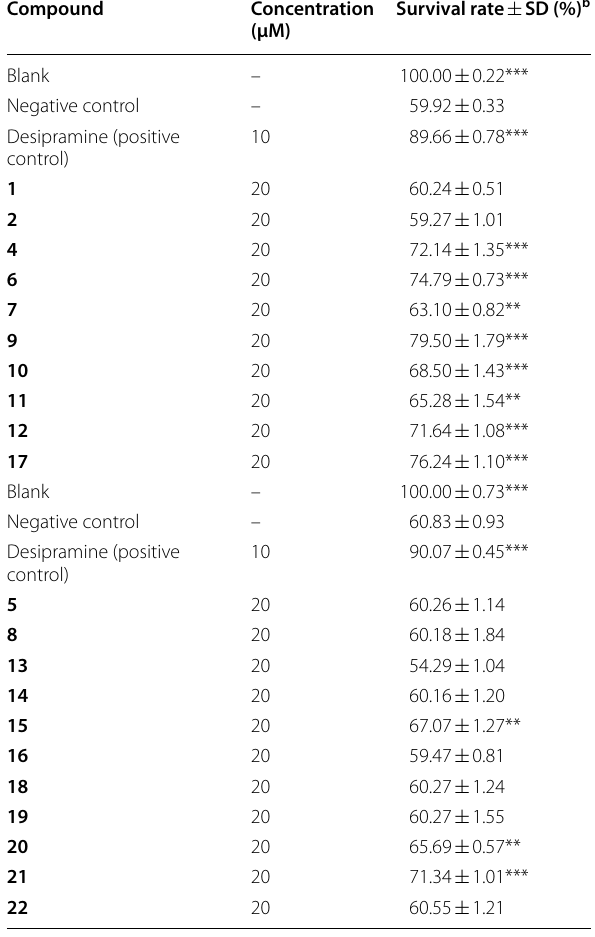
Table 5 The effects of compounds at a single concentration